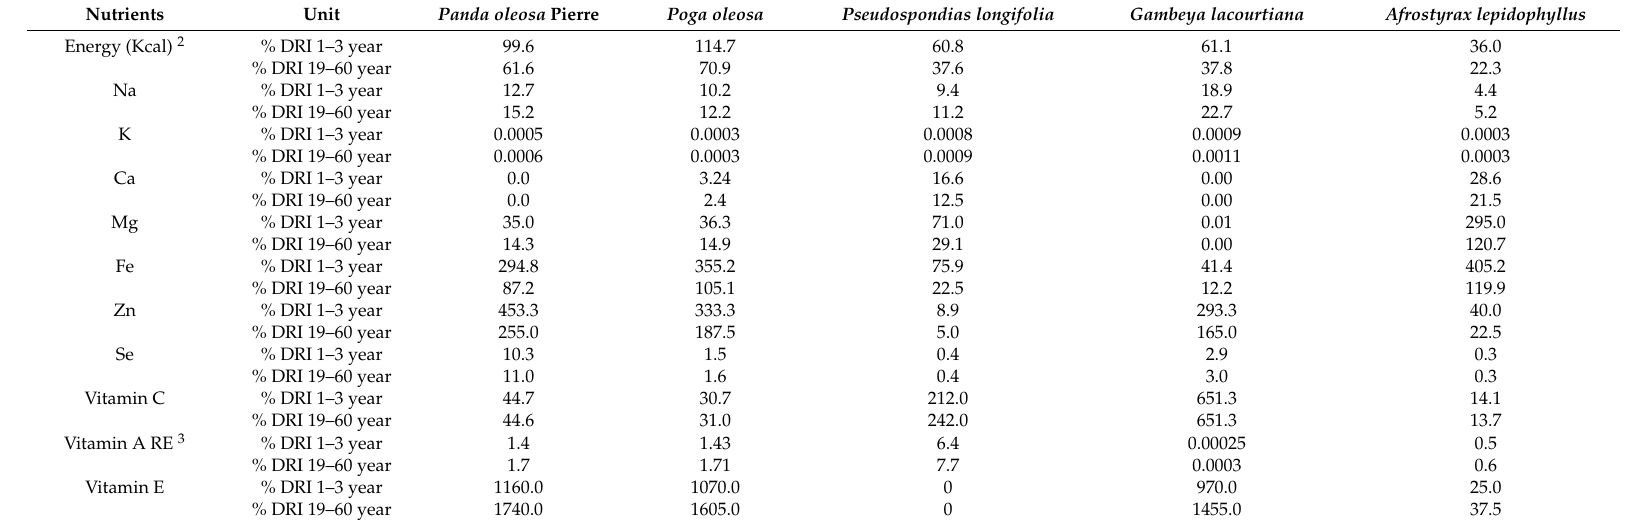
Table 4. Estimated nutrient contribution of the average daily fruit intake 1 to the dietary recommended intakes (DRI) for children aged 1–3 years and women aged 19–60